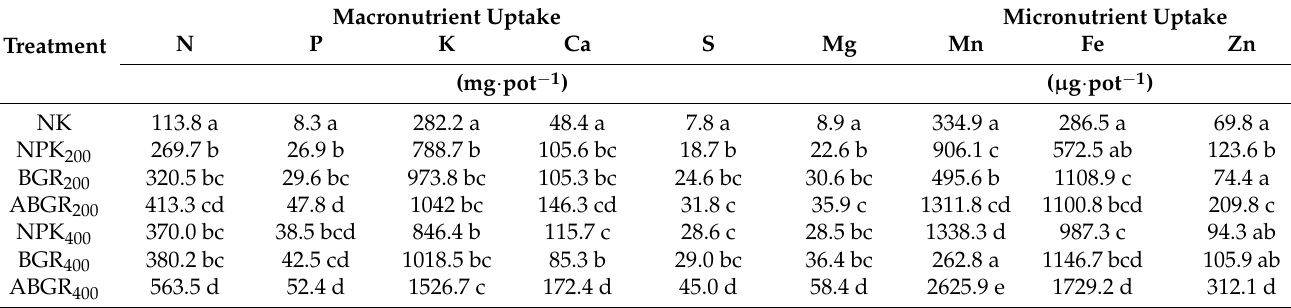
Table 3. Nutrient uptake of selected elements of 8 week old maize shoots ( n = 5) and ANOVA results for each element. Different letters in a column indicate significant differences ( p ≤ 0.05) between treatments. For treatment abbreviations, see Table 1.